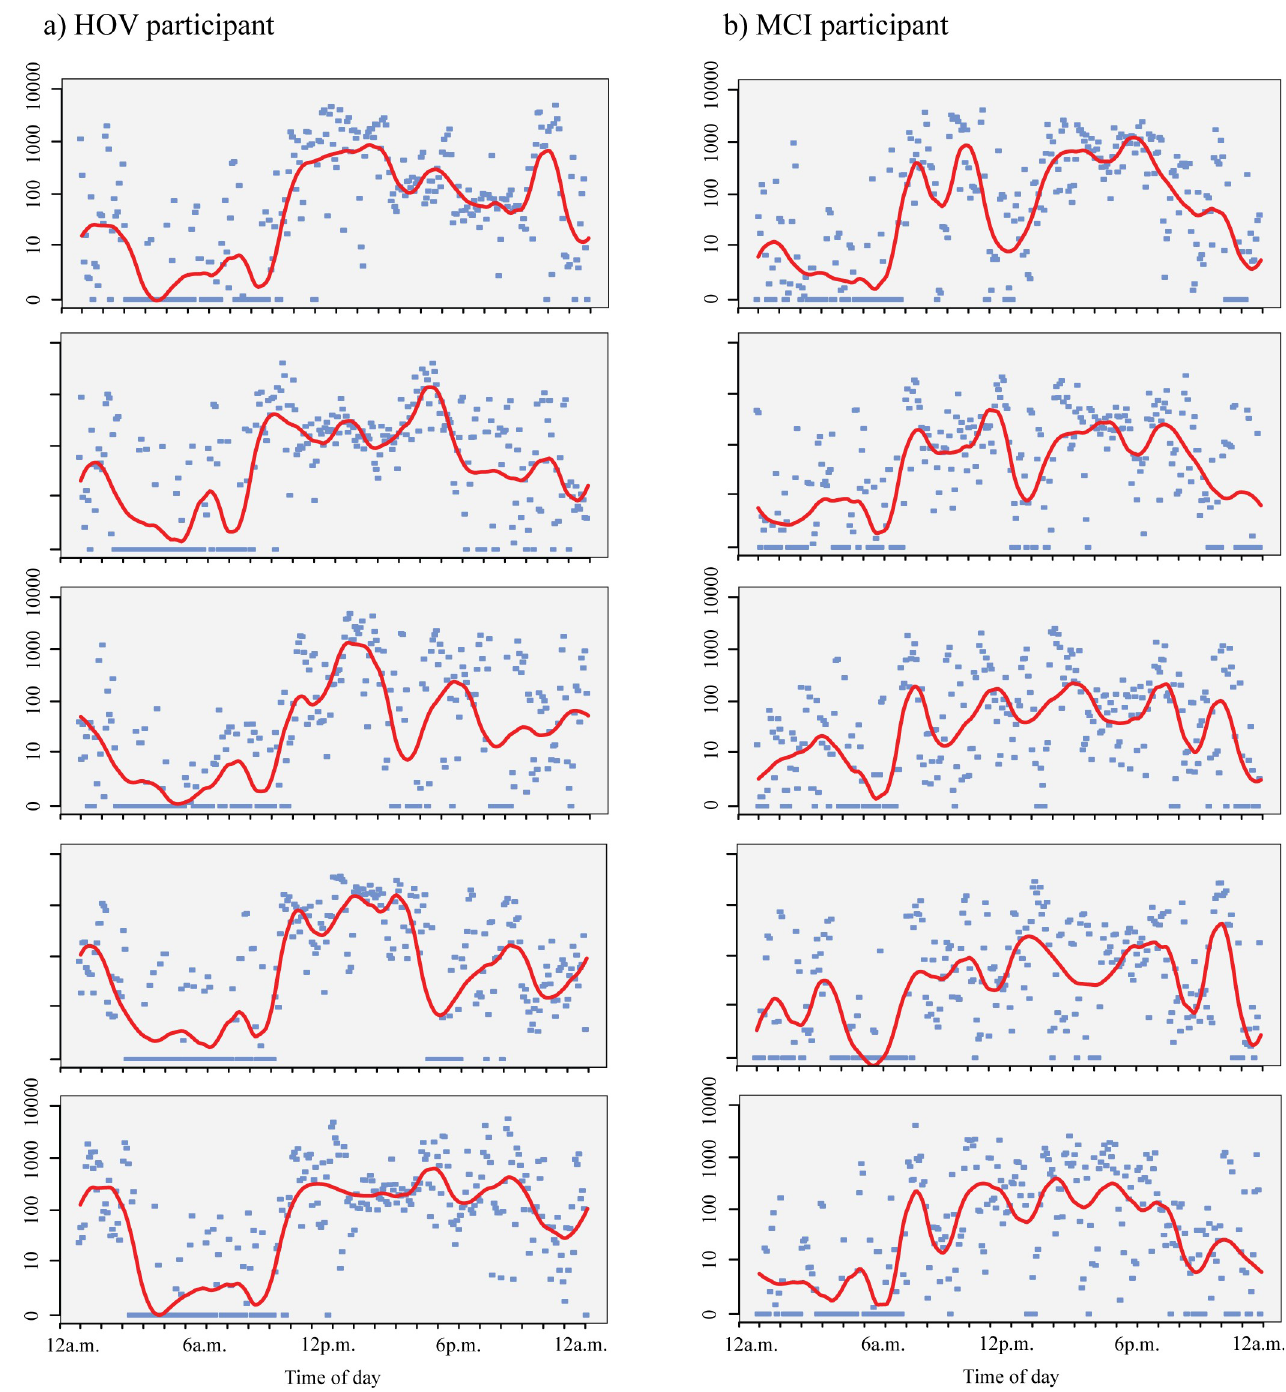
Fig 2. Activity level by time for two sample participants with fitted curve from FoSR. Distribution of absolute activity over a five day period for A) one HOV sample participant and B) one MCI sample participant. Red lines denote the wavelet smoothing.